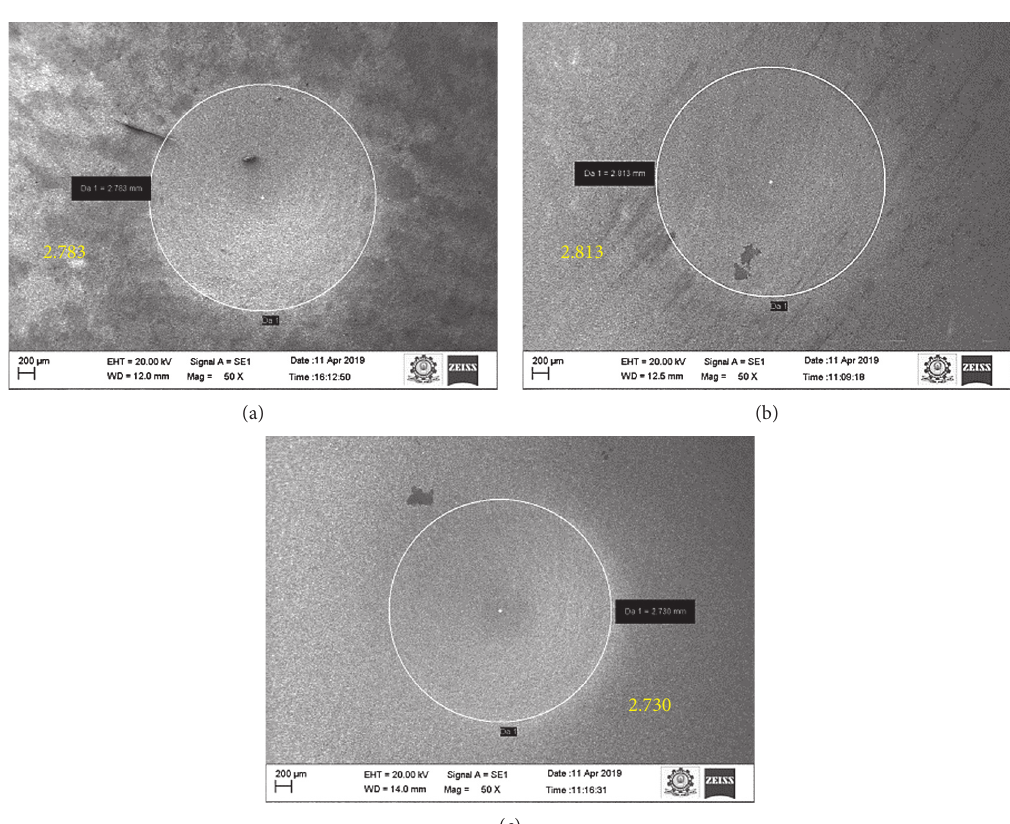
Figure 6: The diameter of erosion scar: (a) bare, (b) HT 1, and (c) HT 2 DMLS